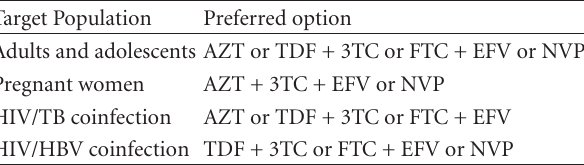
Table 1: Preferred first-line ART in treatment of naive adults and adolescents. Target Population Preferred option Adults and adolescents AZT or TDF + 3TC or FTC + EFV or NVP Pregnant women AZT + 3TC + EFV or NVP HIV/TB coinfection AZT or TDF + 3TC or FTC + EFV HIV/HBV coinfection TDF + 3TC or FTC + EFV or NVP